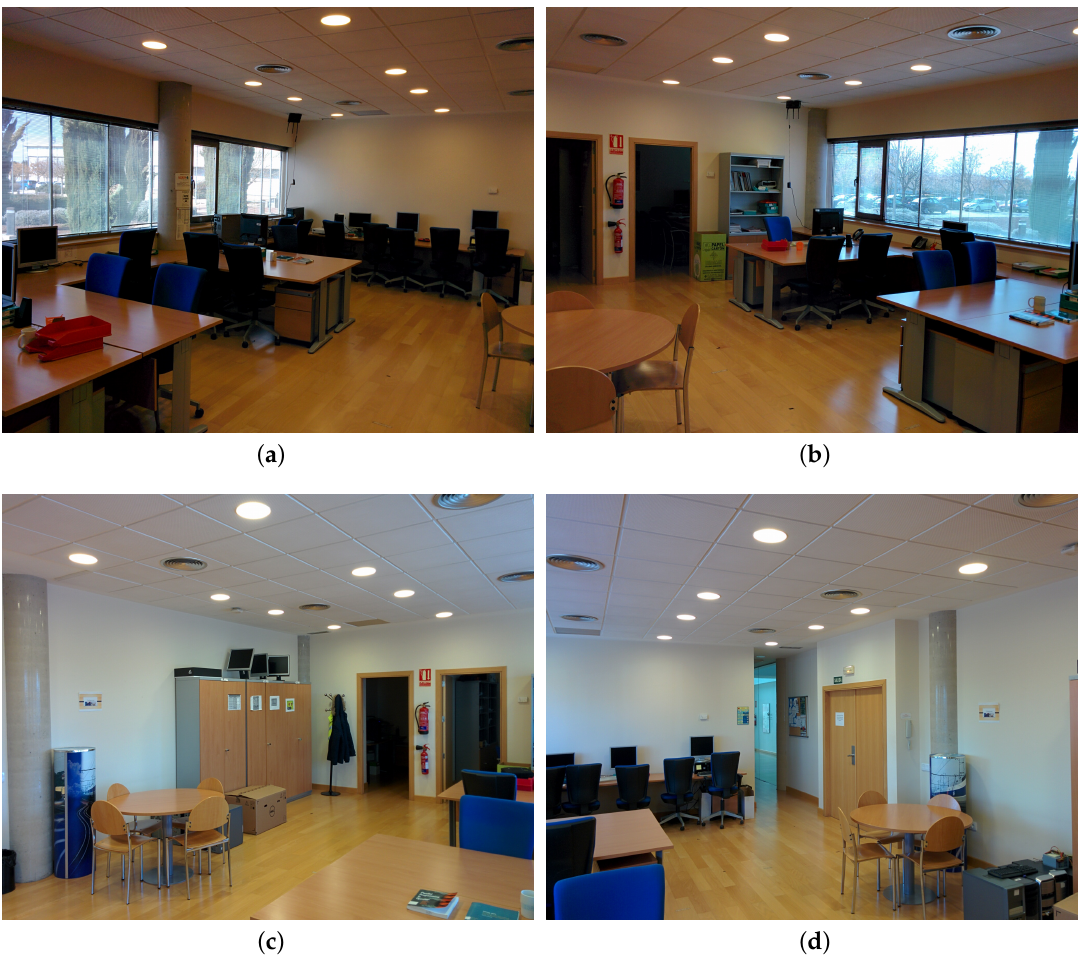
Figure 3. Pictures from each one of the four corners of the lab. ( a ) from Be07; ( b ) from Be08; ( c ) from Be10; ( d ) from